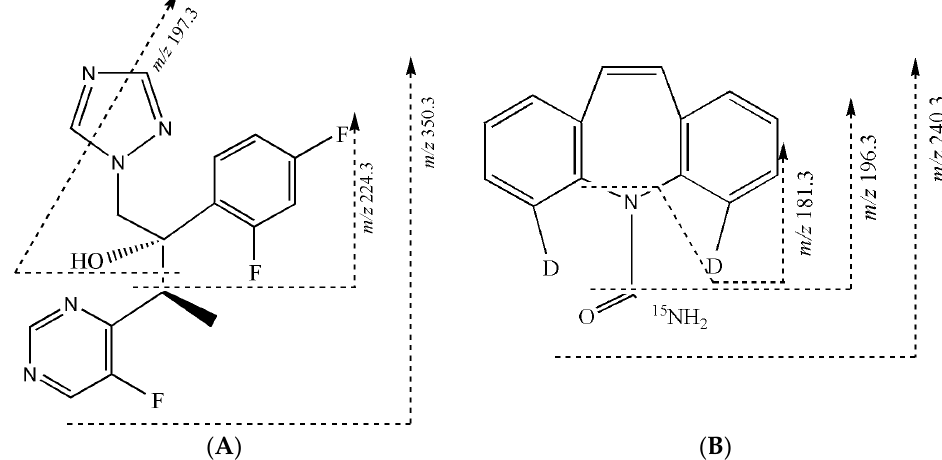
Figure 2. The fragmentation of ( A ) voriconazole and ( B ) carbamazepine-d2,15N. Table 1. Optimized parameters for quantitation of voriconazole using LC-MS 3 .